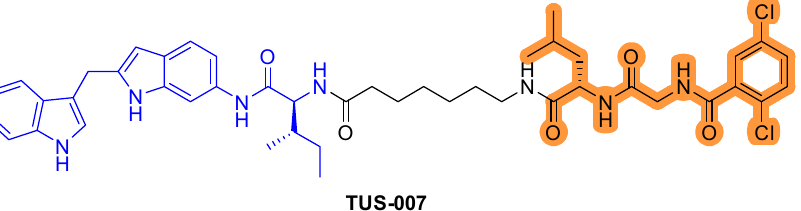
Figure 7. RAS-SOS inhibitor conjugated CANDDY tag. The colors show the part of each compound that it is a structurally important binding motif. CANDDY tag is highlighted in orange.